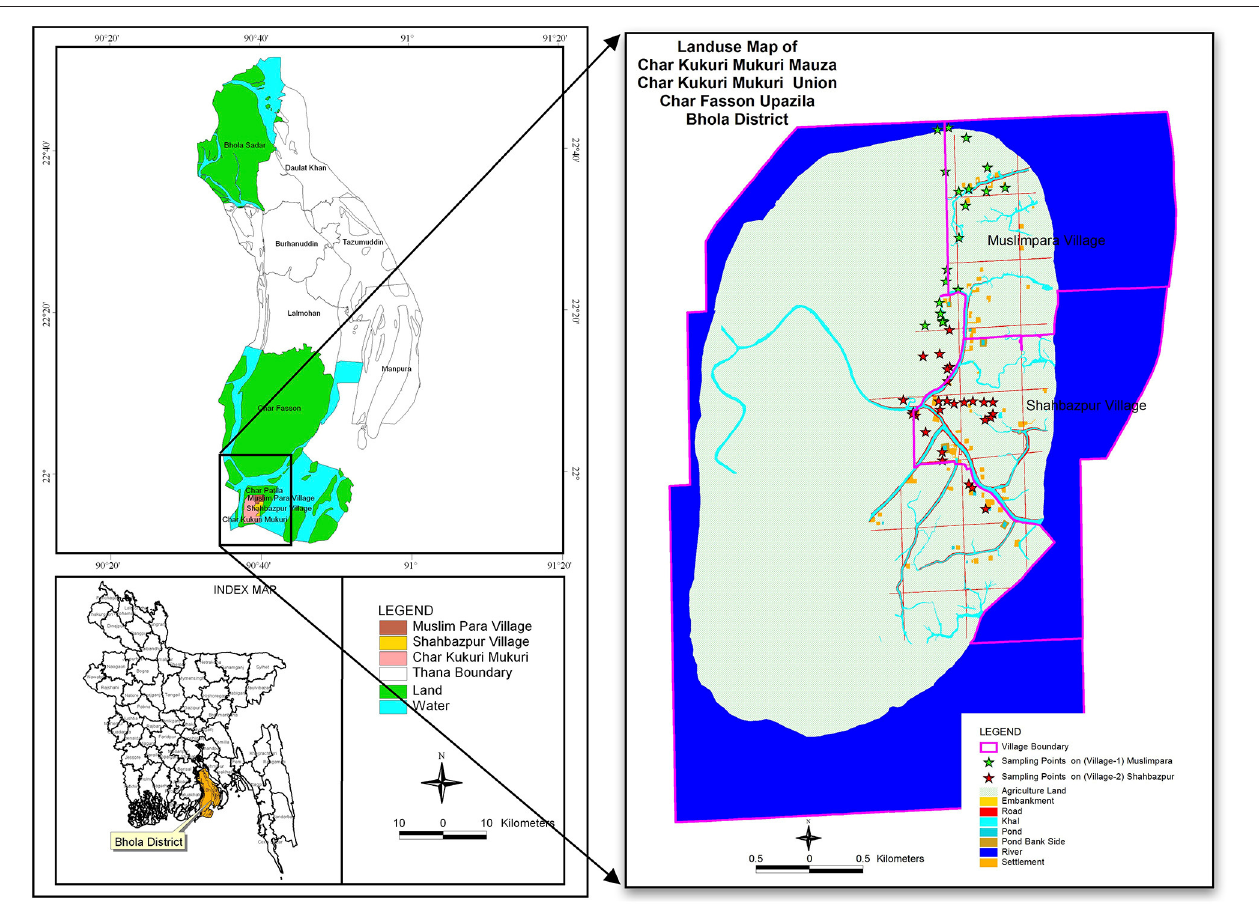
FIGURE 1 | Bhola District of Bangladesh (left) ; Land use map of Char Kukri Mukri Union of Bhola District with the sampling points (location of interviewees) of Muslimpara Village and Shabajpur Village (right) . Created by authors using